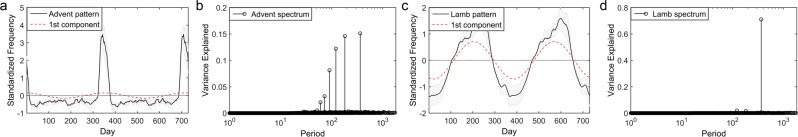
Examples of sinusoidal and complex waveforms in the time domain, and their Fourier spectrums from the UK corpus.(a) shows the most complex periodic waveform (advent) in the time domain, while (b) shows the corresponding Fourier spectrum where we can see several components are activated. (c) shows the most sinusoidal periodic waveform (lamb) in the time domain, with (d) showing the corresponding Fourier spectrum where we can see that only one component is strongly activated, explaining nearly 80% of the variance in the time domain.